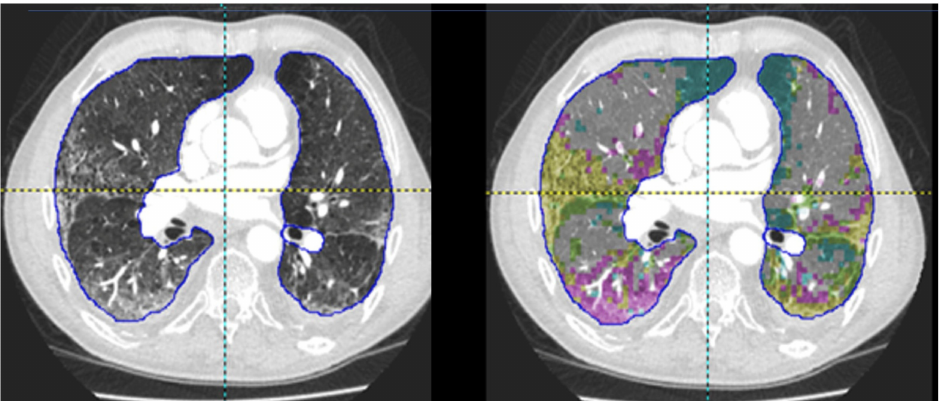
Figure 6. Demonstration of a quantitative CT (QCT) approach (adaptive multiple features method), acquired using PASS software. Different lung parenchymal disease patterns are identified and highlighted. Blue, emphysema/low attenuation pattern. Yellow, fibrotic changes. Pink, ground glass